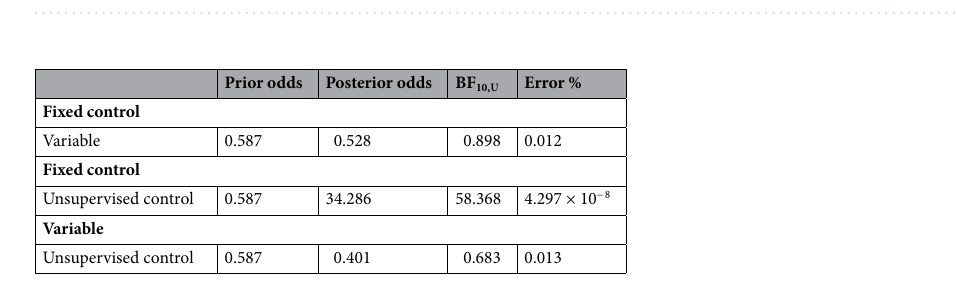
Table 1. Model comparison for improvement in number of correct sequences performed (Bayesian repeated measures ANOVA).